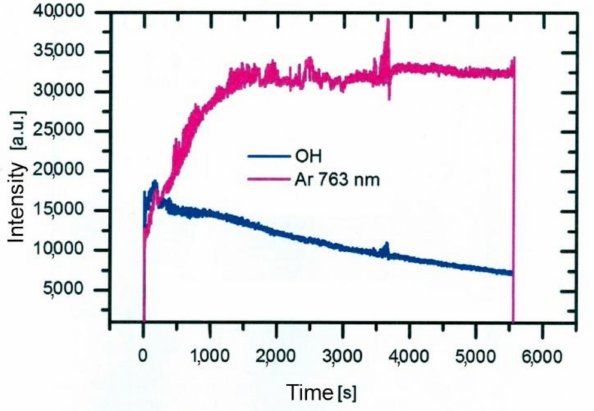
Figure 7. Stability and time evolution of Ar and OH lines after ignition of the APPJ